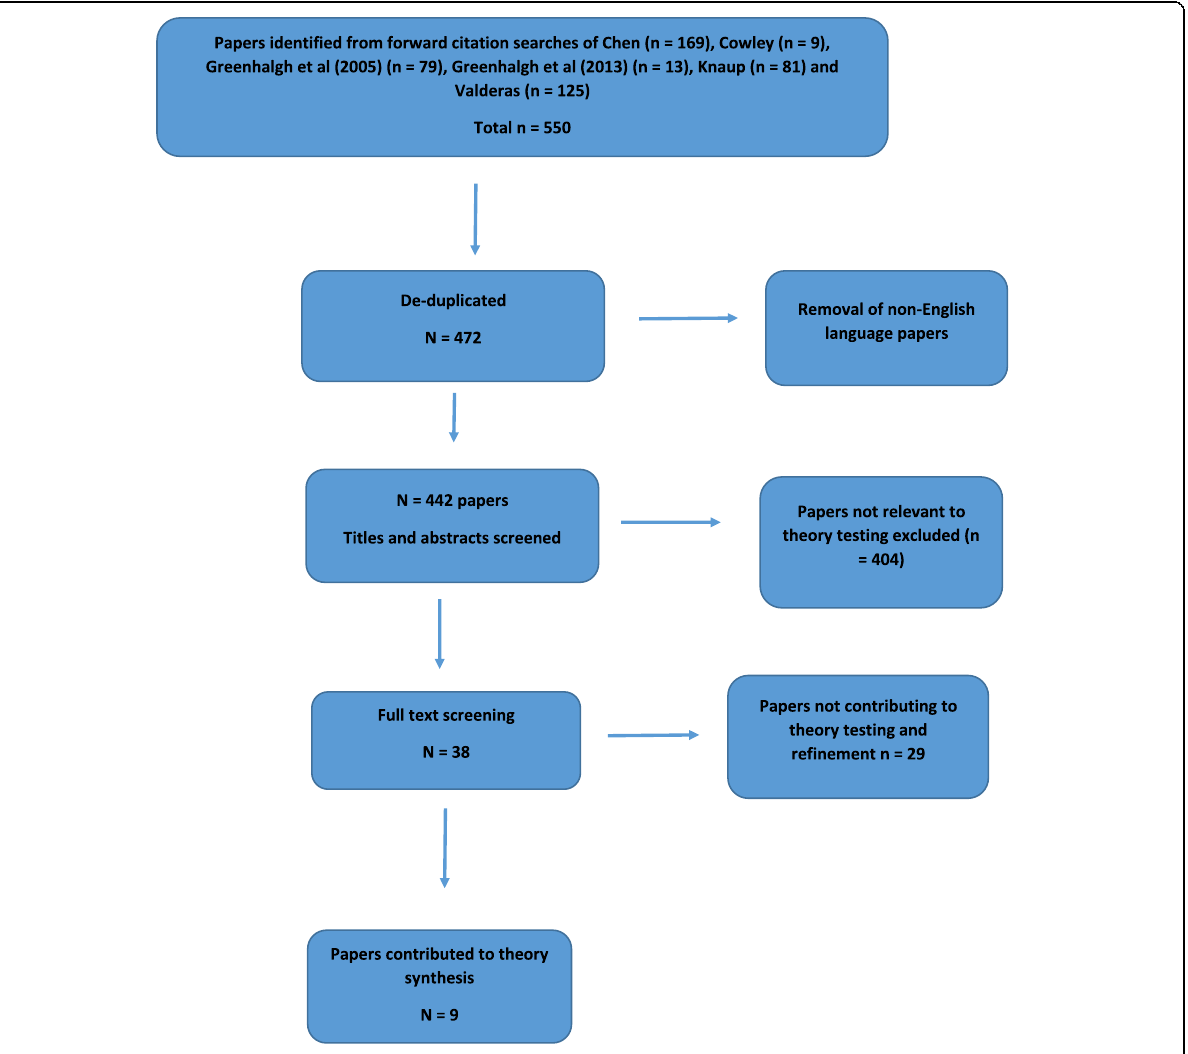
Fig. 3 Selection of papers from citation searches conducted in February